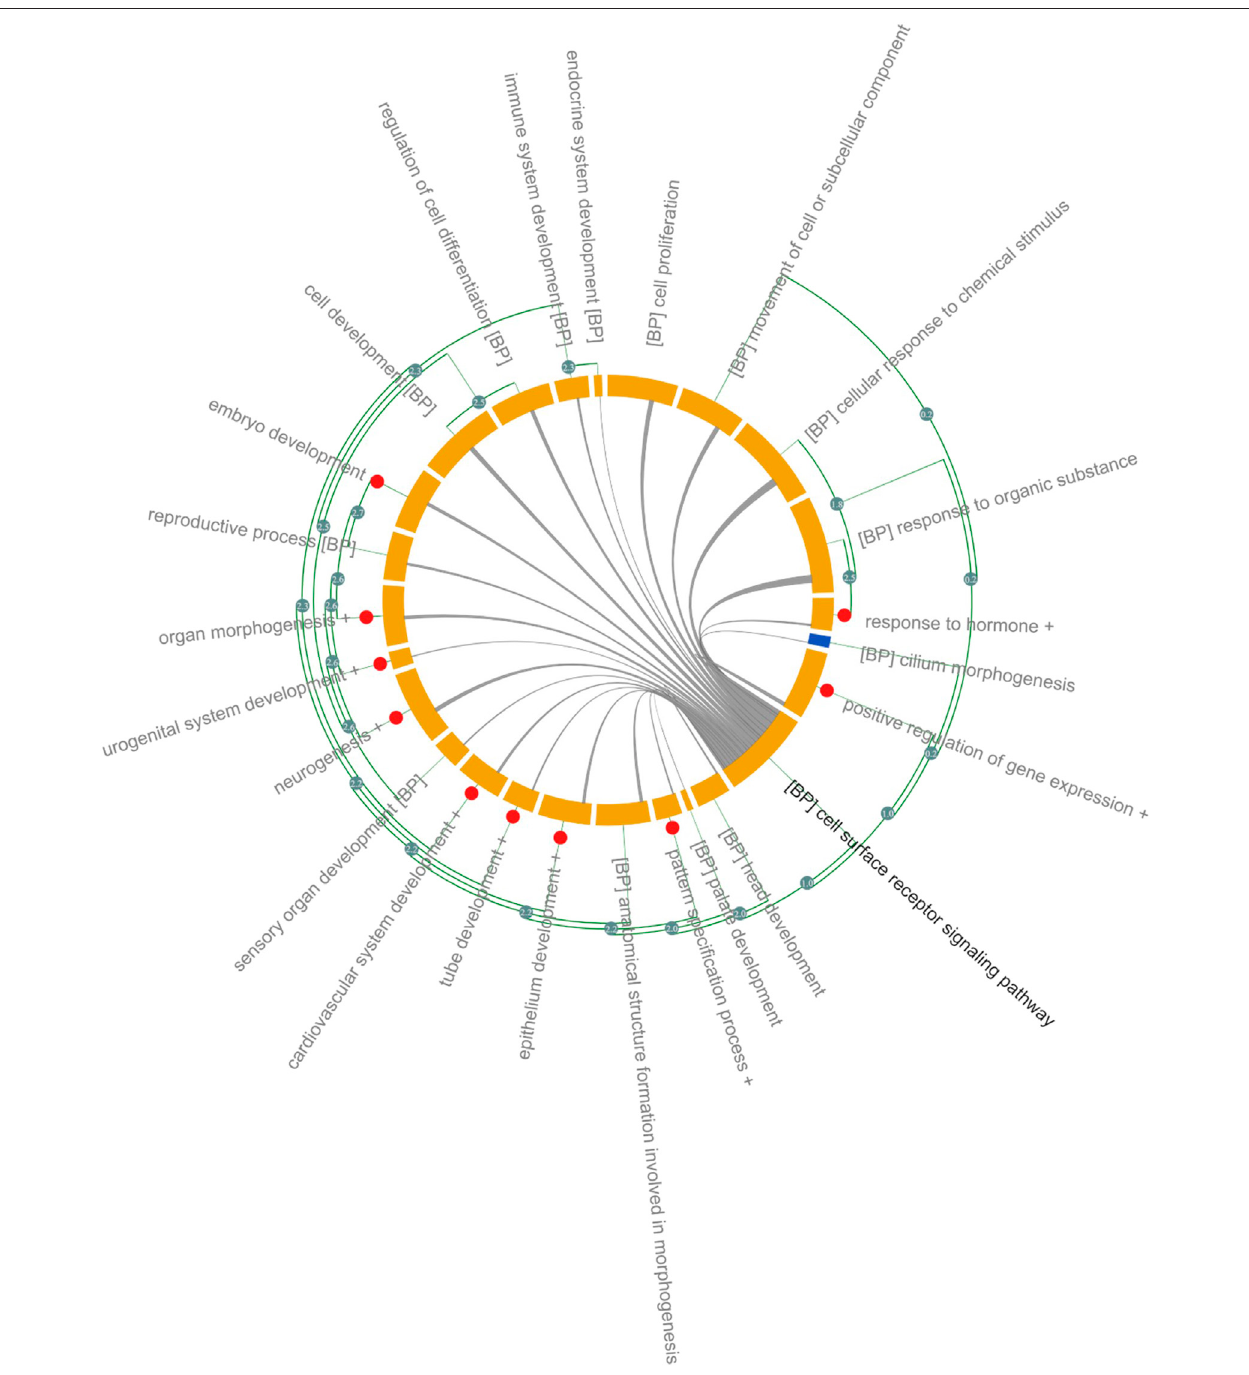
FIGURE 2 | Gene Ontology Analysis of DARTable genome. Chord diagram (Xin et al., 2020) showing overrepresented (FDR corrected p < 0.05) GO-BP in the HumanDARTableGenomefrom(A).GO-BPandwereclusteredbasedonResnicksimilaritybetweenterms.Eachelement(orange)onthediagramrepresentsaGO-BP or clustered terms (Resnik similarity score > 2.7) which are represented asred circles. The length ofthe element isproportional tothe number of genesrelated tothe GO- BP or clusterofGO-BPs.The green edgesparalleltothe mainchord diagram on the outsideshowpossible clustersbetweenterms. The edges insidethe diagram show shared genes between the GO-BPs and the width of the edges is proportional to the size of the overlap. In this example, GO-BP cell surface receptor signalling pathway (bolded) shares genes with sensory organ development, chemical response to stimulus and response to organic substance compared to endocrine system development. Percentage overlap between cell surface receptor signalling and other GO-BP can be found in Supplementary File S2 .